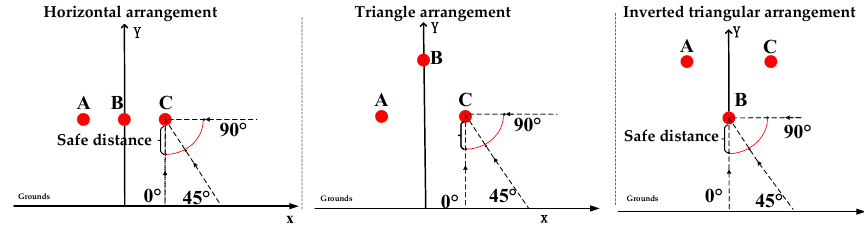
Figure 6. Schematic diagram of K value calculation path.